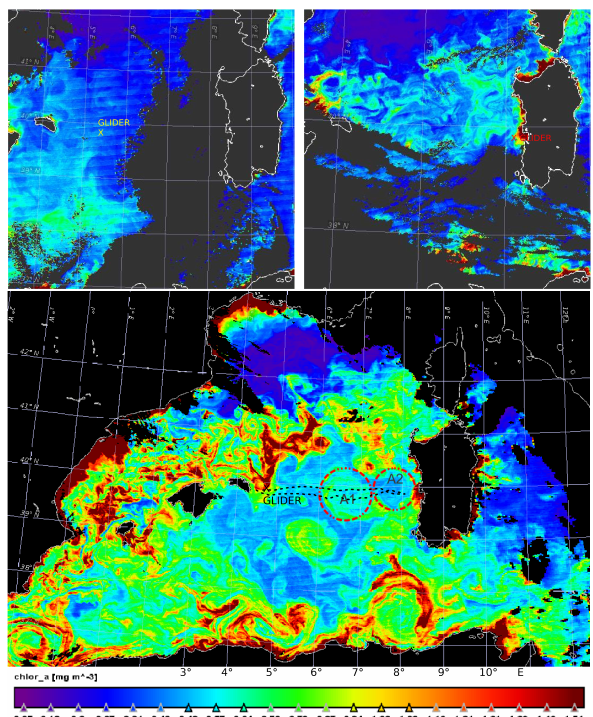
Figure 5. AQUA MODIS chlorophyll a concentrations for: Fig. 5. AQUA MODIS Chlorophyll-a concentrations for: 4 February 2013 (top left), 19 February 2013 4 February 2013 (top left), 19 February 2013 (top right), and (top right) and 8 March 2013 (bottom); the onset of the bloom along the front and near the margins of 8 March 2013 (bottom); the onset of the bloom along the front and the big Algerian eddy south of Sardinia is evident in the last image. The glider position is superimposed near the margins of the big Algerian eddy south of Sardinia is evi- on each image. Anticyclones crossed by the glider are visible in the last image (A1 and A2). dent in the last image. The glider position is superimposed on each image. Anticyclones crossed by the glider are visible in the last im- 21 age (A1 and A2).